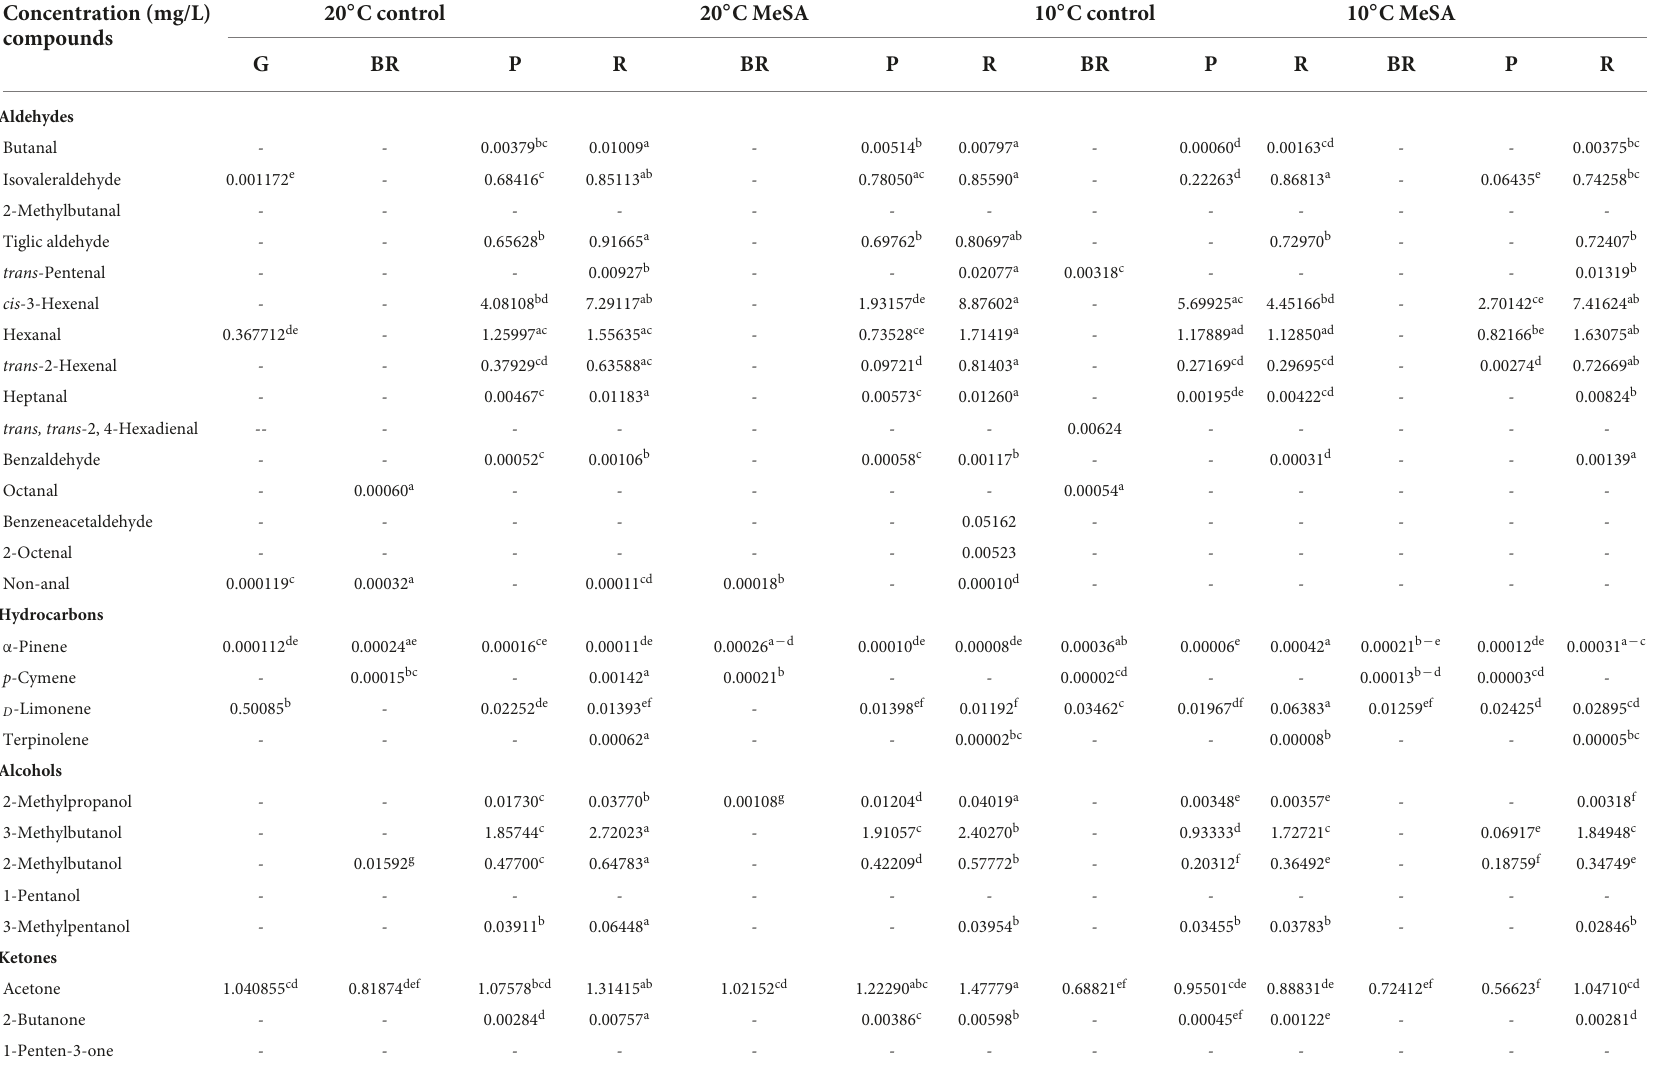
TABLE 2 Effects of methyl salicylate (MeSA) pre-treament on the volatile profiles of tomato fruits stored at low temperature. Concentration (mg/L)